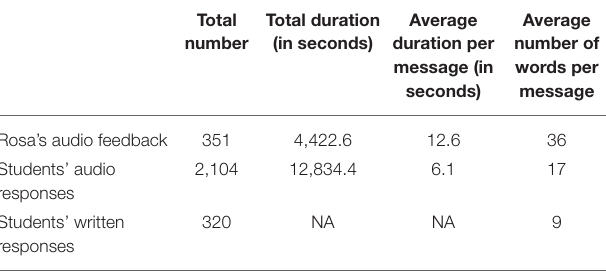
TABLE 2 | Descriptive statistics of Rosa’s audio feedback and students’ audio